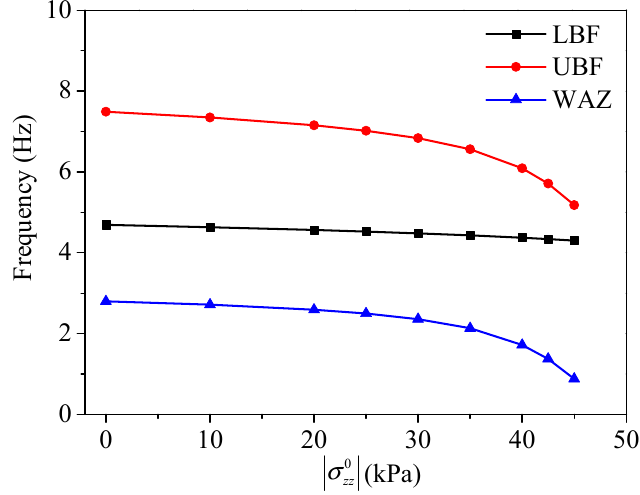
Figure 6. Complete attenuation zone changing with the compressive initial stress.